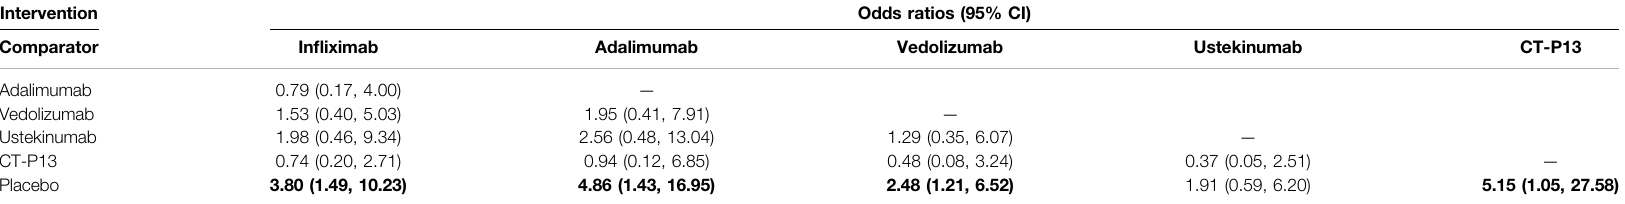
TABLE 4 | Pairwise comparisons of steroid-free